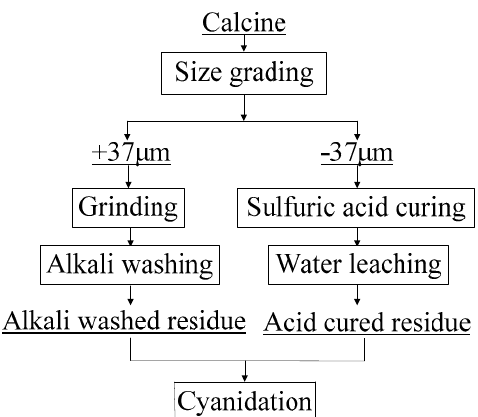
Figure 5. Process flowsheet of enhancing gold leaching from the calcine by purposeful pretreatments for different size fractions.